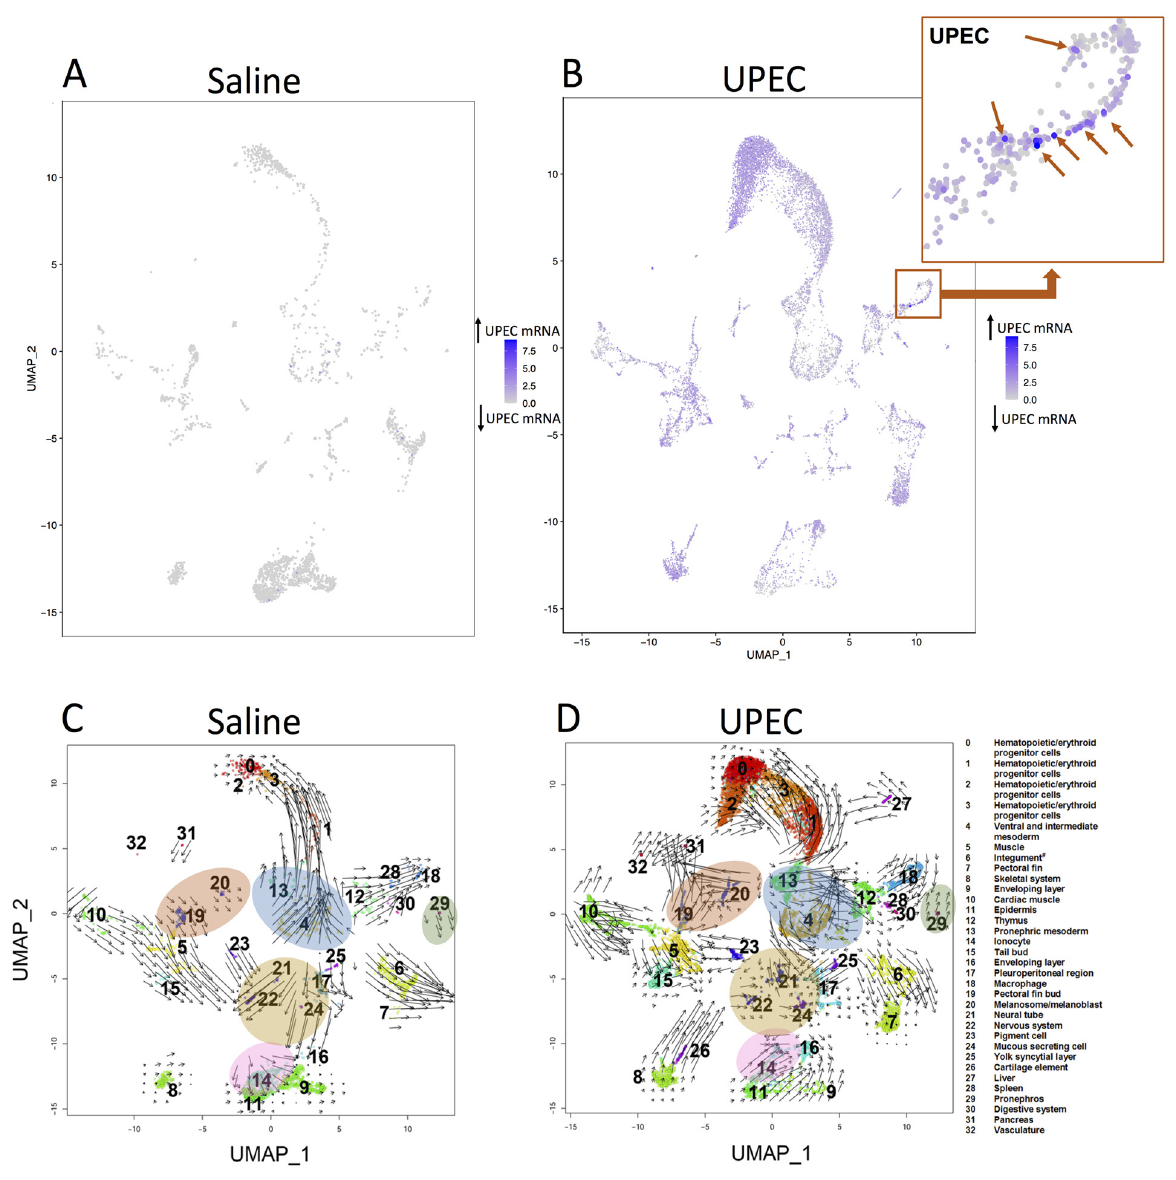
Figure 2 : UPEC localization and RNA velocity at the single cell level. Compared to saline injected embryos (A) , UPEC injected embryos (B) have diffuse UPEC expression. Some clusters such as Cluster 18 (macrophages) have cells with very high UPEC expression. The macrophage cluster (digital zoom box, upper right of (B) have isolated cells with very high UPEC mRNA (arrows). Only cells included in the initial UMAP plot are included. Therefore, some cells with high UPEC expression did not meet the filtering criteria. RNA velocities of saline (C) and UPEC (D) exposed cells are presented. The arrow direction demonstrates the direction that a cluster’s transcription pattern is developing towards, while the arrow length is representative of transcription activity with a longer arrow indicating more transcription activity. Areas of high transcription activity and RNA velocity direction changes are noted following UPEC exposure. For example, the transcriptional pattern in pronephros cells (cluster 29) is moving away from macrophages (cluster 18) when injected with saline (C), but is moving towards them when